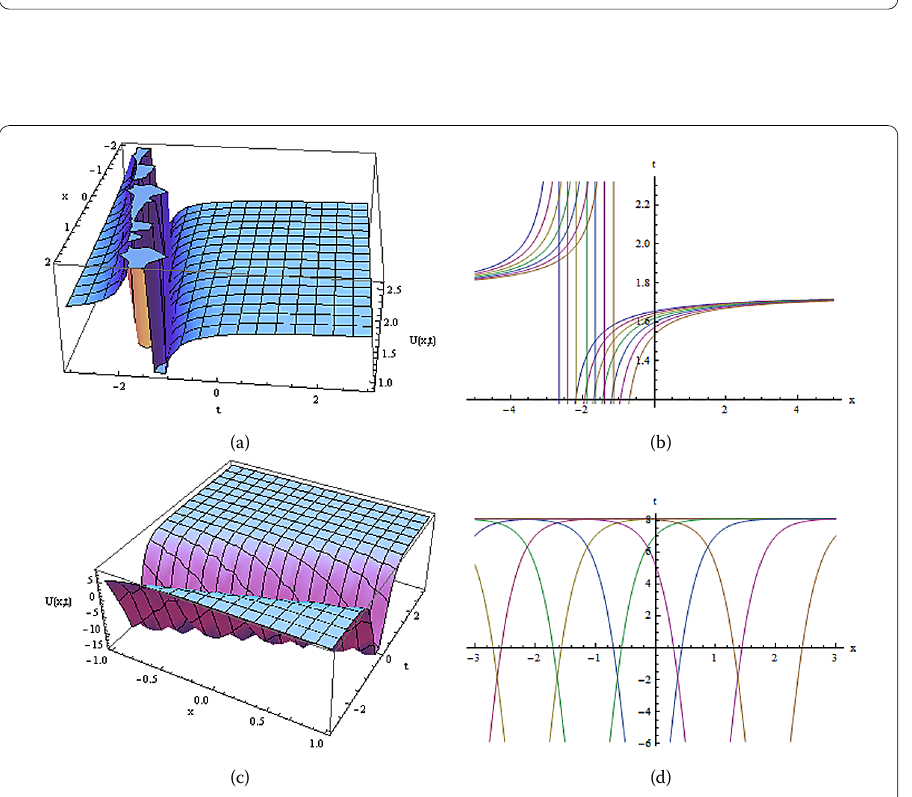
Figure 2 The 3D surfaces of Eq. (9) for solution (17) at ( a ) and of Eq. (18) for solution (24) at ( b ) are plotted by passing on with different values of the parameters under constrain conditions on the